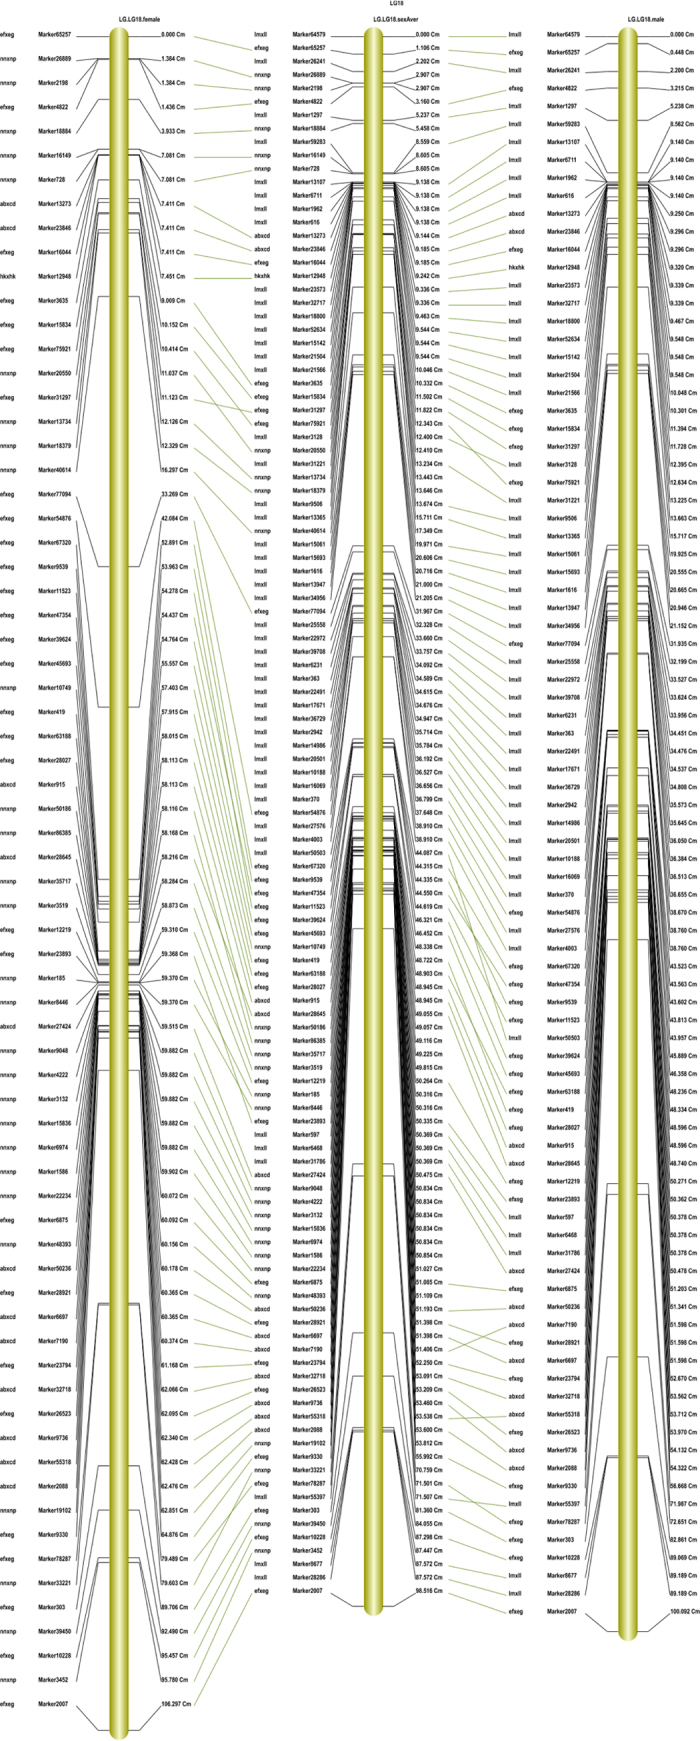
Demonstration of synteny analysis between female, male and sex average map.